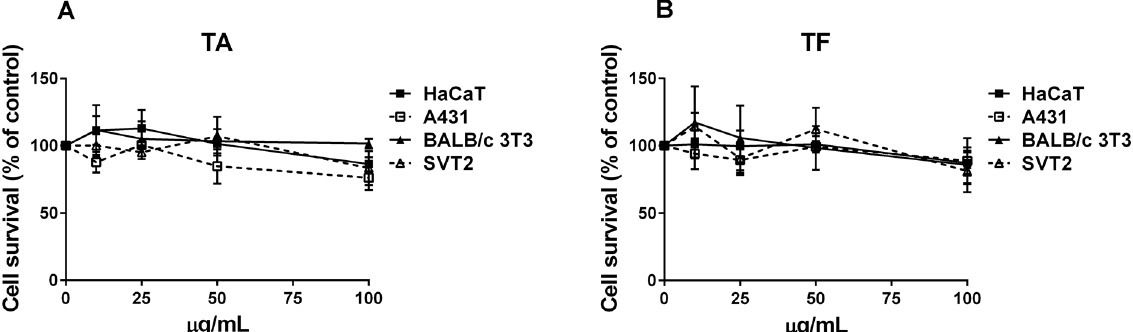
Figure 1. Immortalized and cancer cells viability after treatment for 48 h with increasing concentrations of T. algeriensis (TA) ( A ) and T. fontanesii (TF) ( B ) extracts (10 – 100 µg/mL). HaCaT (black squares), A431 (empty squares), BALB/c-3T3 (black triangles), and SVT2 (empty triangles) cells. Cell viability and cell survival were assessed according to method described in the section of materials and methods.